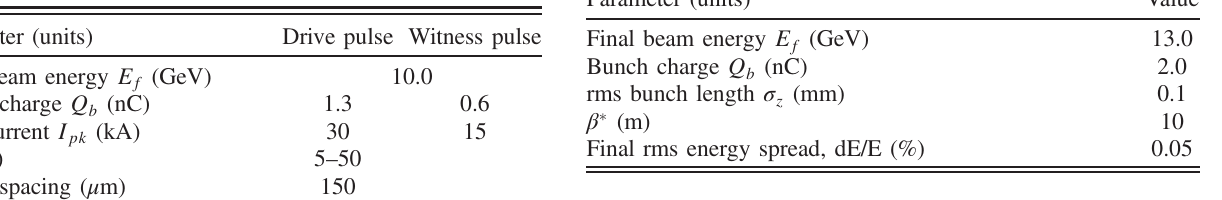
TABLE III. Two-bunch mode parameters. β (cid:3) refers to the optical beta function magnitude at the interaction waist in sector 20.